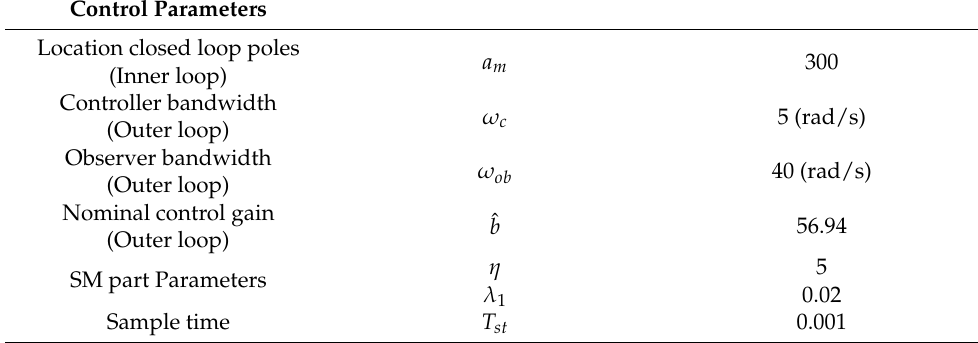
Table 2. The control